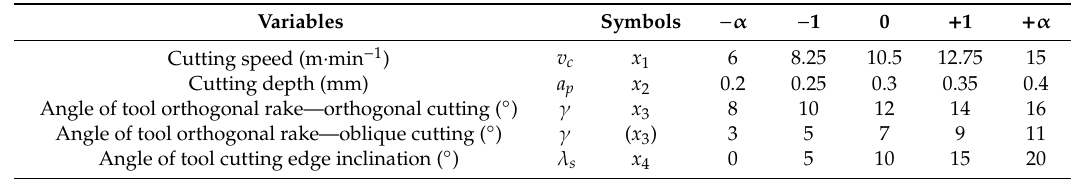
Table 4. The variables and ranges of individual values.